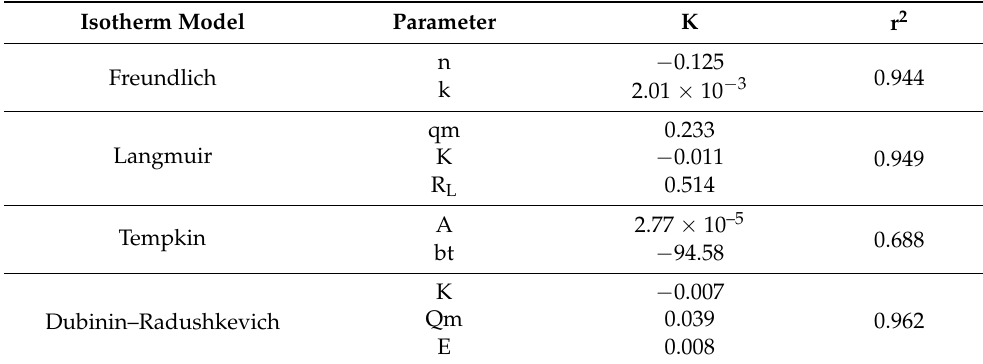
Table 4. Cr (VI) adsorption isotherm parameters for the JTT sample.